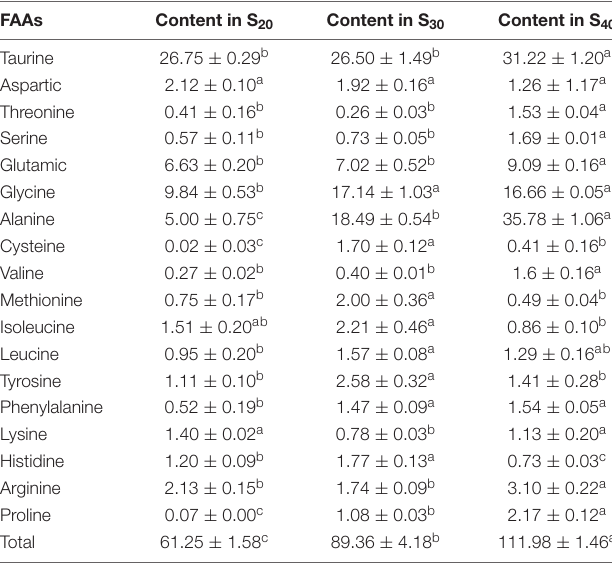
Different superscript letters in the same column mean significant difference (P < 0.05).